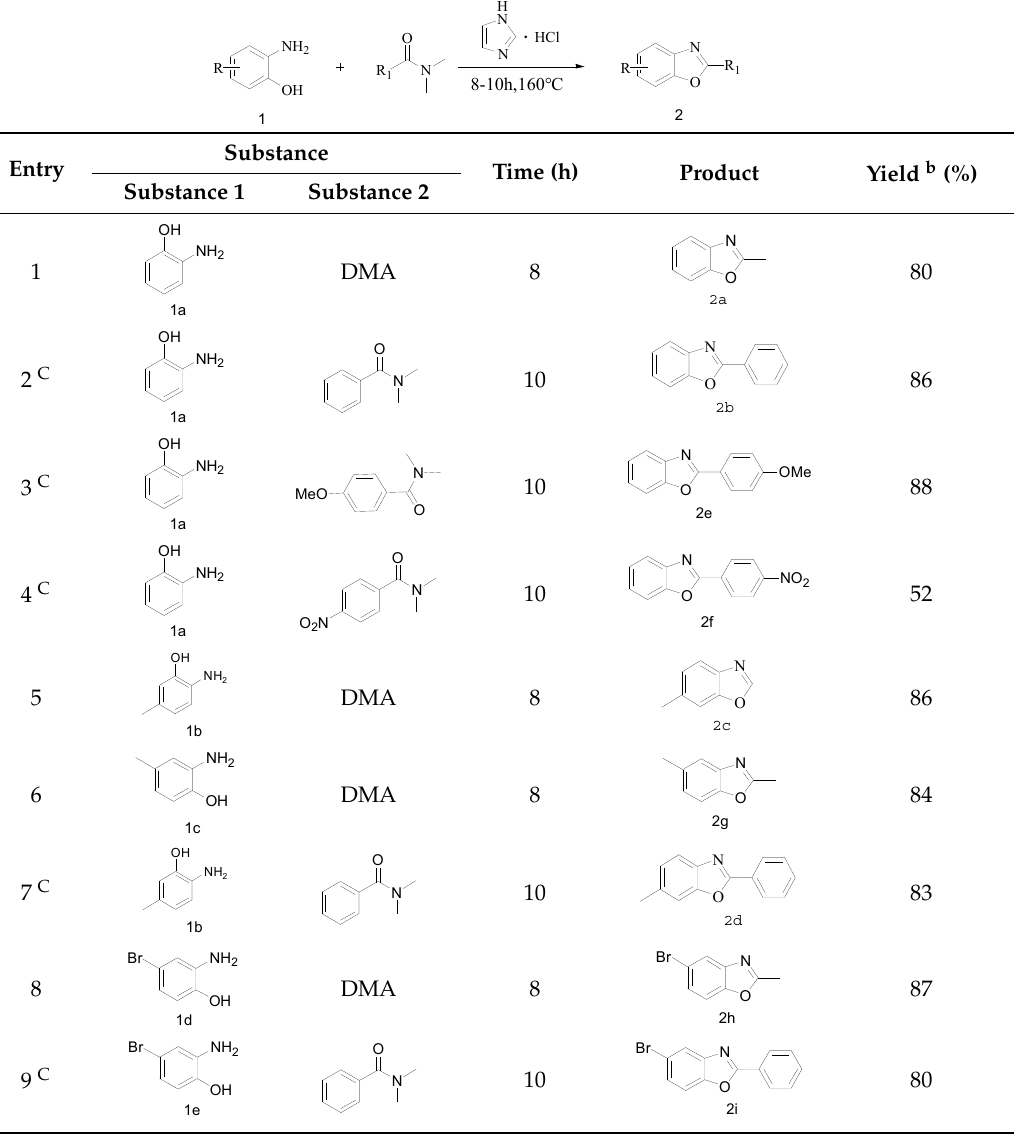
Table 3. Substrate scope with respect to substituted 2-aminophenols a .